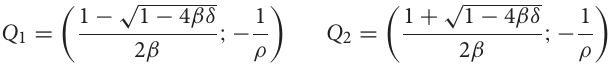
Figure 7A , obtained with ρ